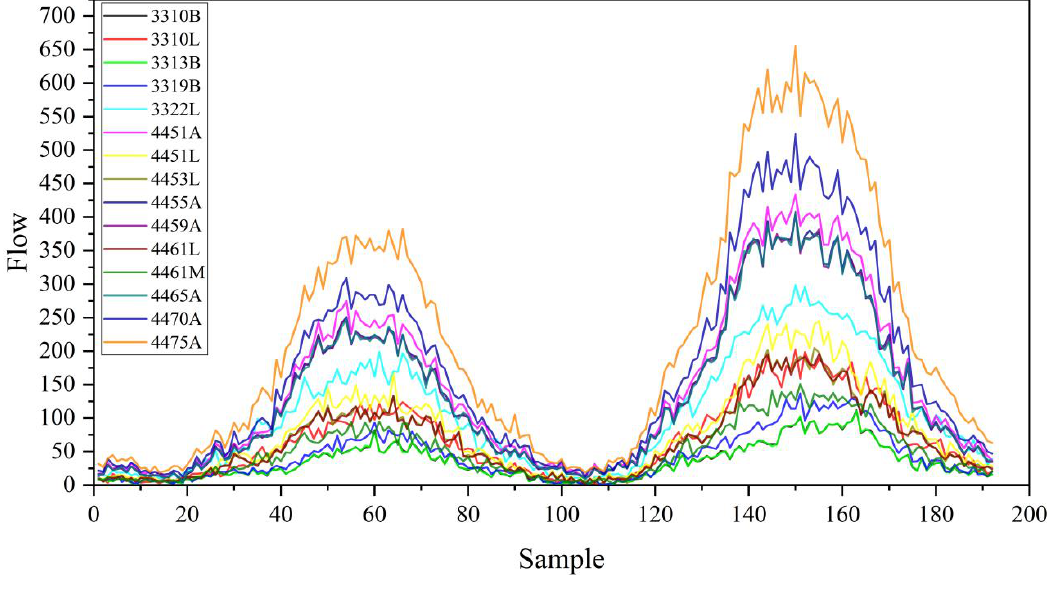
Figure 7. Detection point data distribution. Table 2. Detection point numbers under different combinations.